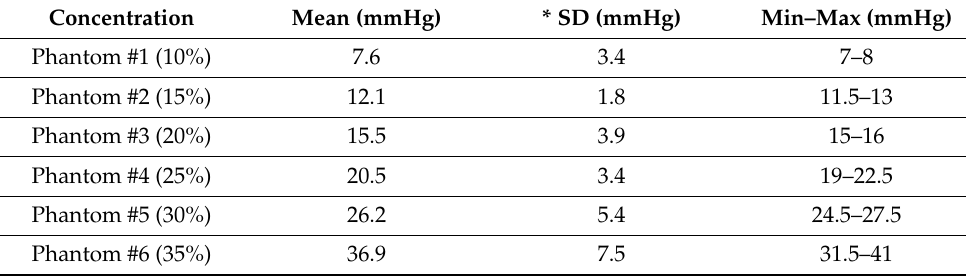
Table 3. Measured IOP data using the rebound